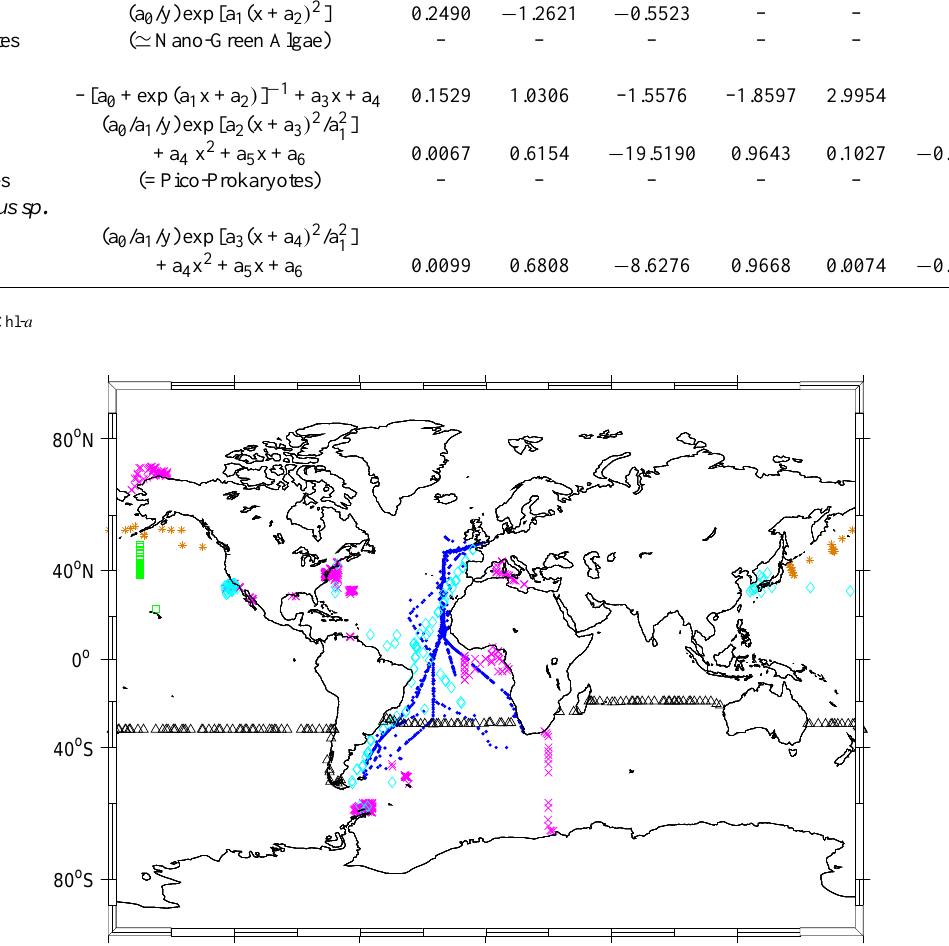
Fig. 1. Distribution of phytoplankton pigment data used in this study; blue dot: the NERC AMT cruise (Aiken et al., 2009), black triangle: the JAMSTEC BEAGLE cruise (Barlow et al., 2007), cyan diamond: the NASA NOMAD (Werdell and Bailey, 2005), magenta cross: the NASA SeaBASS, brown star: the SEEDS II cruise (Suzuki et al., 2005) + A-line stations (Isada et al., 2009), green square: the HU Oshoro-maru